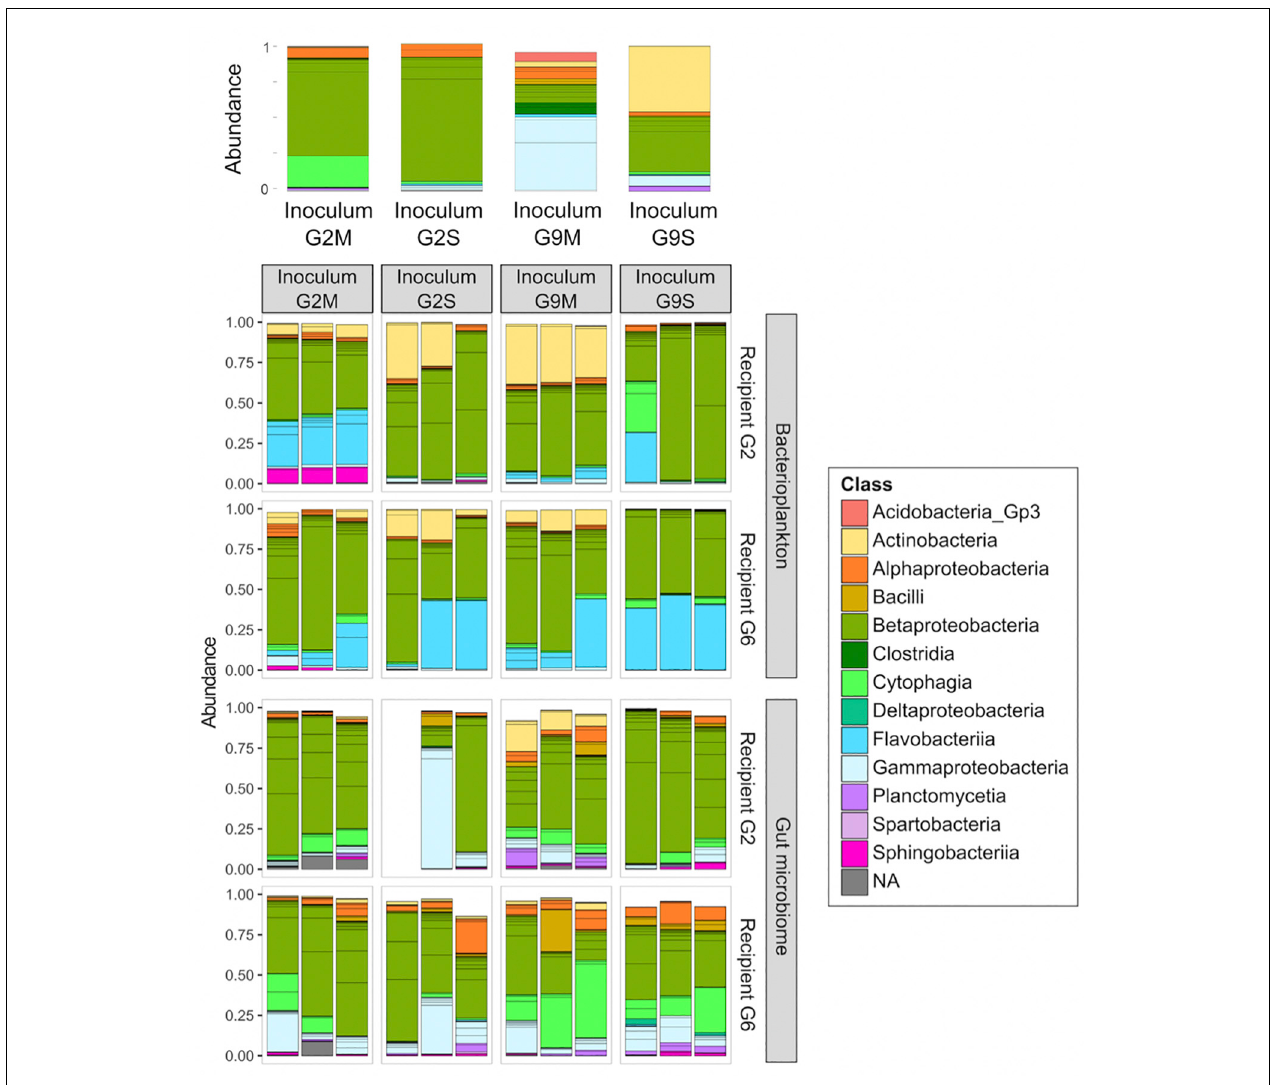
FIGURE 2 | BPK and GM composition in recipient Daphnia genotypes following a GM transplant (Experiment 2). Two germ-free recipient Daphnia genotypes (G2 and G6) were inoculated with four types of microbial inocula (G2M, G2S, G9M, and G9S). Two weeks after the transplant, both Daphnia GM and BPK were characterized through next generation sequencing ( n = 3 replicated populations per recipient genotype × inoculum combination). Bars indicate the relative abundance of OTUs. Colors indicate bacterial classes. OTUs with an occurrence lower than 1% are not represented. Upper panel is the GM composition of the